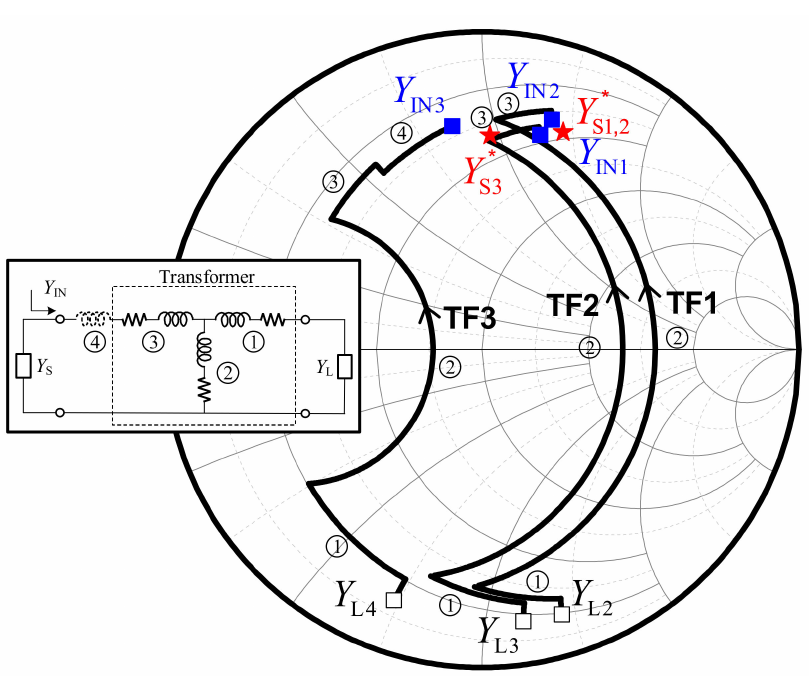
Figure 4. Admittance derived from 3D EM results (blue squares), the admittance from the modeled lumped components (black solid lines), and conjugate source admittance (red stars) of the TF1, TF2, and TF3 at each interstage in the 4-way